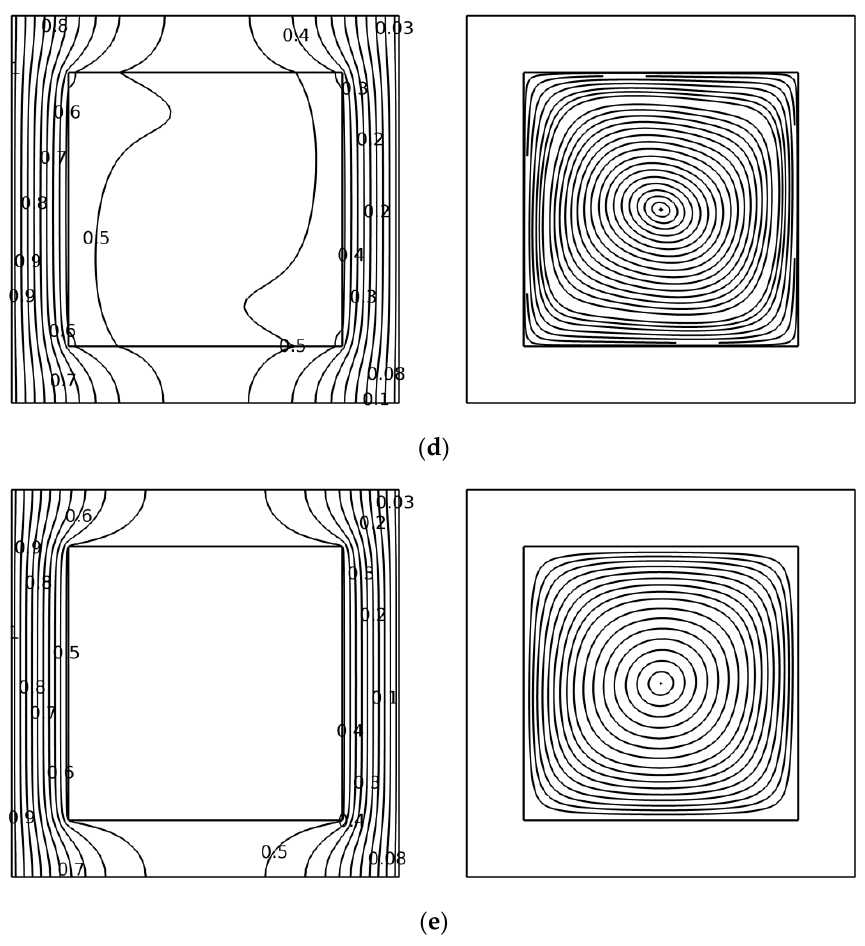
Figure 10. Streamlines and isothermals obtained for ( a ) Nr = 10 − 1 , W max = 80.698, ( b ) Nr = 10 0 , W max = 79.533, ( c ) Nr = 10 1 , W max = 66.759, ( d ) Nr = 10 2 , W max = 29.962 and ( e ) Nr = 10 3 , W max = 6.1957.